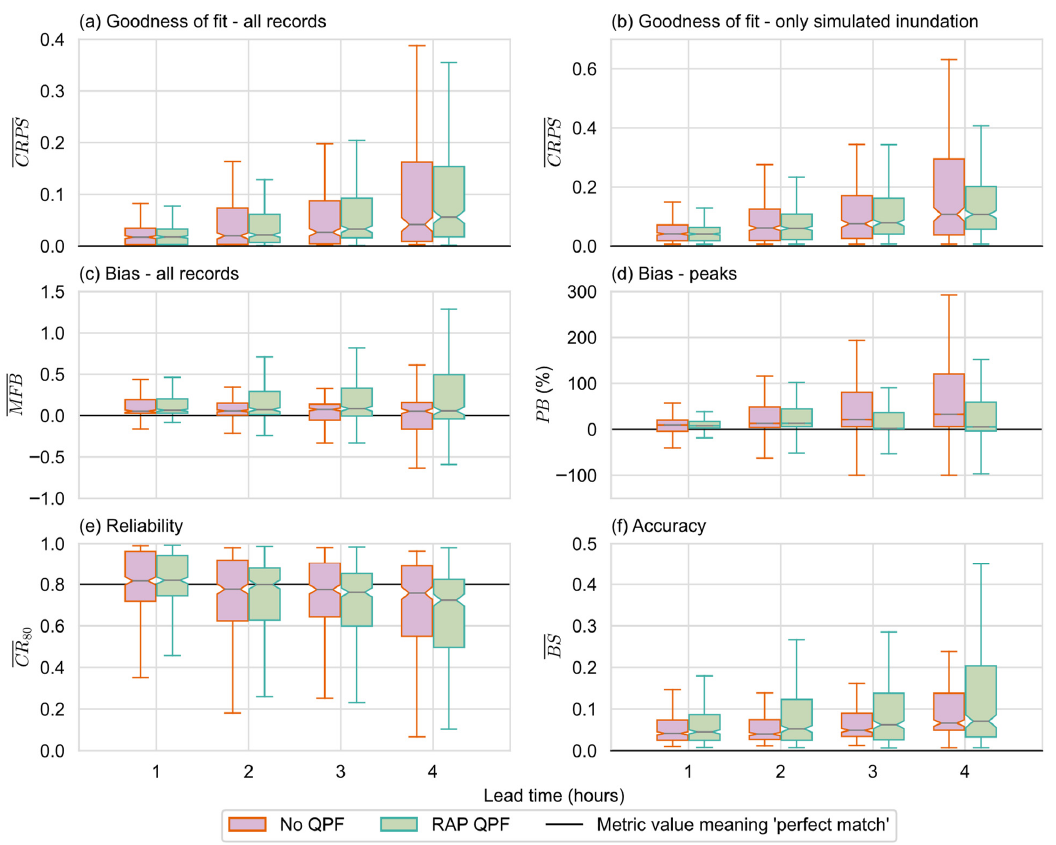
Figure 8. General performance metrics of the no-QPF and the QPF-aware surrogate models.